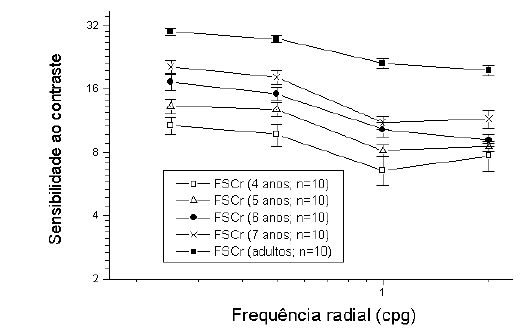
Figura 2 . Funções de sensibilidade ao contraste de crianças de 4, 5, 6 e 7 anos e adultos para freqüências radiais (FSCr). O n representa o número de curvas mensuradas para cada faixa etária. As linhas verticais mostram o erro padrão da média para cada freqüência (0,25; 0,5; 1 e 2